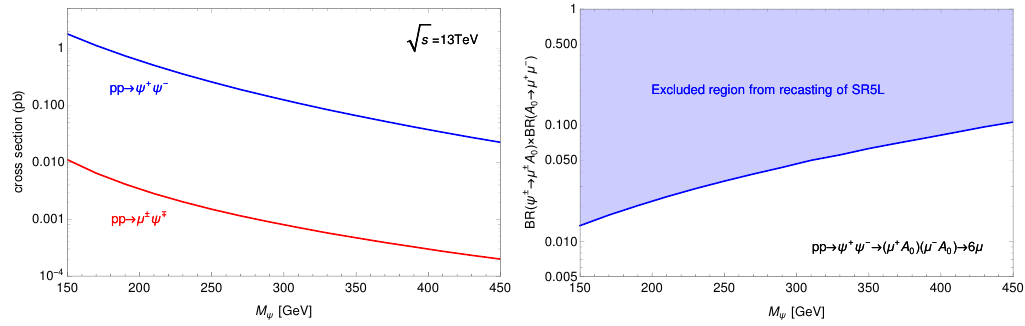
√ s = 13 TeV. We fix from 150 − 450 GeV. Right panel: exclusion limit ψ ( ψ ± → µ ± A ) × BR ( A + µ − )) ψ , BR 0 0 → µ